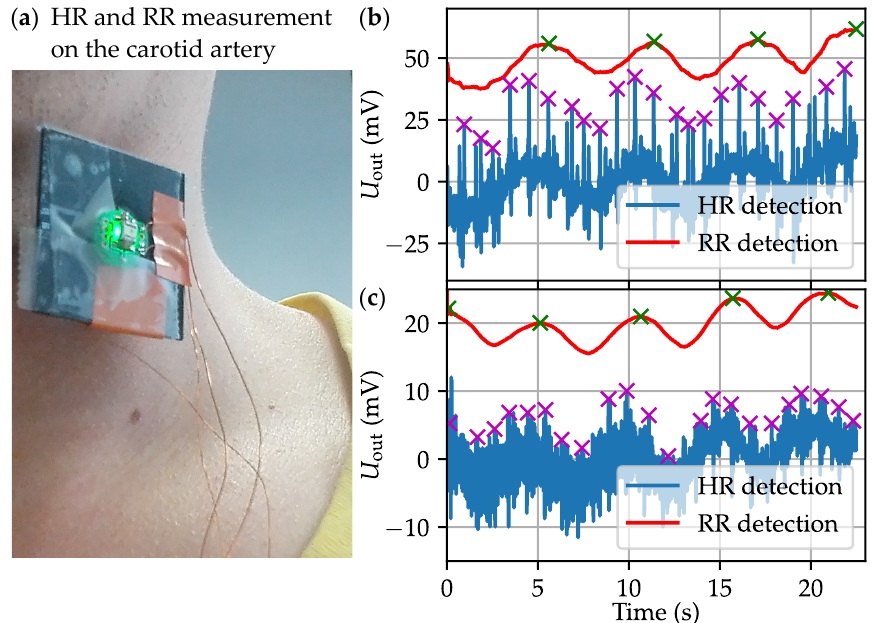
Figure 3. ( a ) Sensor stack placed on the cartoid artery for HR and RR measurement. ( b ) Result of a measurement with the inorganic sensor stack. The blue curve shows the waveform recorded with an oscilloscope already showing distinctive peaks corresponding to the heart rate (HR). These peaks were automatically identified and marked (magenta crosses). The respiration rate (RR) was extracted with a moving average filter applied onto the data of the blue curve leading to the red curve and green crosses. The curve was moved upwards by 50mV for better visibility of both waveforms. ( c ) Result of a measurement with the organic sensor stack. It can be seen that the signal-to-noise ratio of the organic stack is not as good as for the inorganic one. This may be due to the difficult alignment of the sensor components. Nevertheless, HR and RR both were